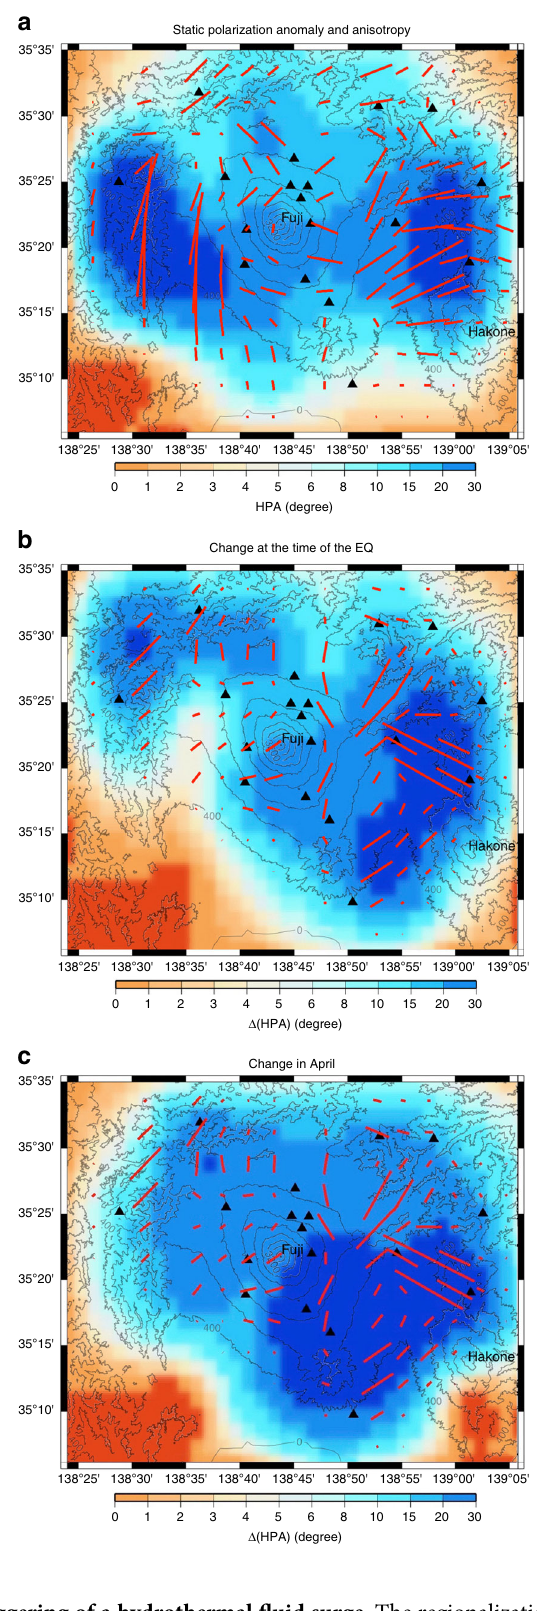
Fig. 3 Regionalization of the horizontal polarization anomaly (HPA): a Map of the regionalized static anisotropy through 2011. Red lines, average orientation of static anisotropy. The lengths of the red lines and the color bar de fi ne the amplitudes of the static HPA through 2011. b Map of the regionalized co-seismic changes in anisotropy computed for a time window of 7 days centered on the date of the Tohoku-Oki earthquake. c Map of the regionalized sharp changes in anisotropy in April computed for a time window of 7 days, covering the decrease period of the HPA (Fig. 2a). Red lines, mid-orientation of anisotropy between before and after the changes. The lengths of the lines and the color bar de fi ne the amplitudes of the HPA temporal changes over the 7 days. a – c Black triangles, seismic stations; gray lines, topography contour lines. The regionalized orientation of the anisotropy is determined with a lateral resolution of ≈